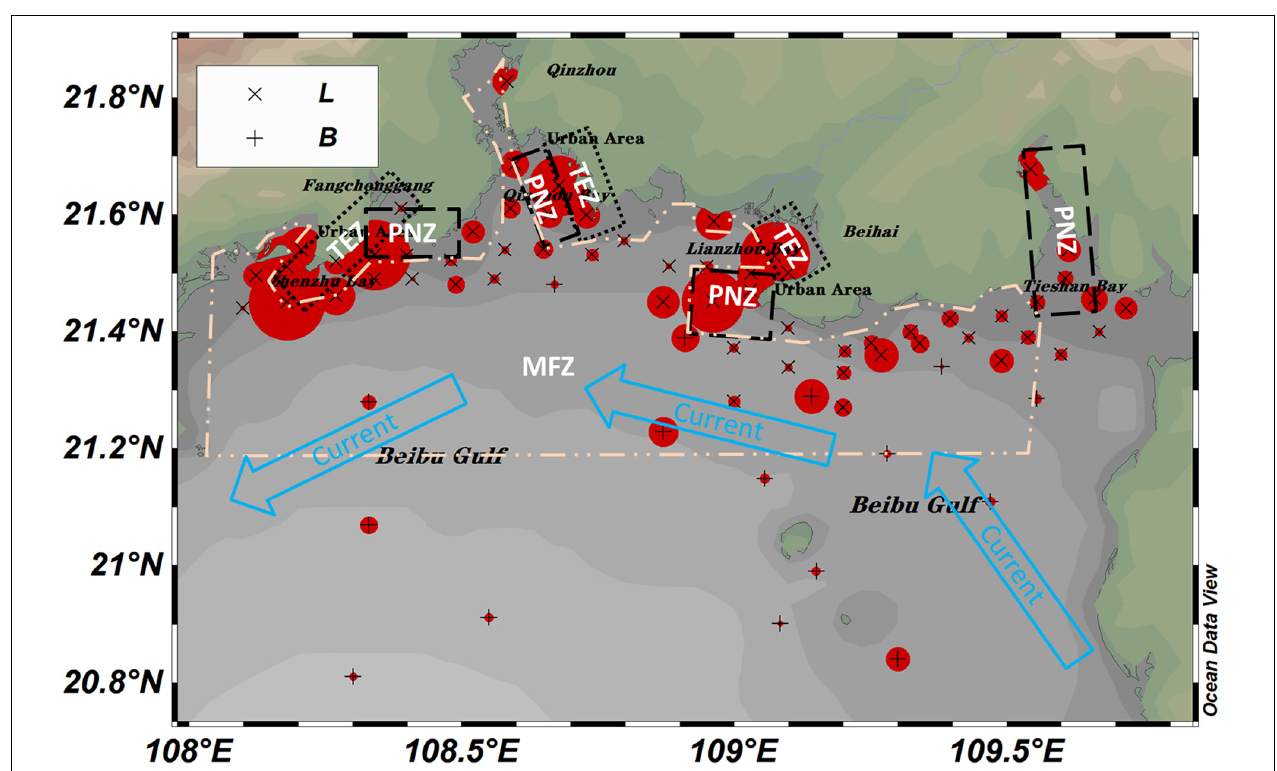
FIGURE 5 | Distributions of microplastics in seawater from L and B stations. MFZ, Mariculture and Fishery Zone; TEZ, Tourism and Entertainment Zone; PNZ, Port and Navigation